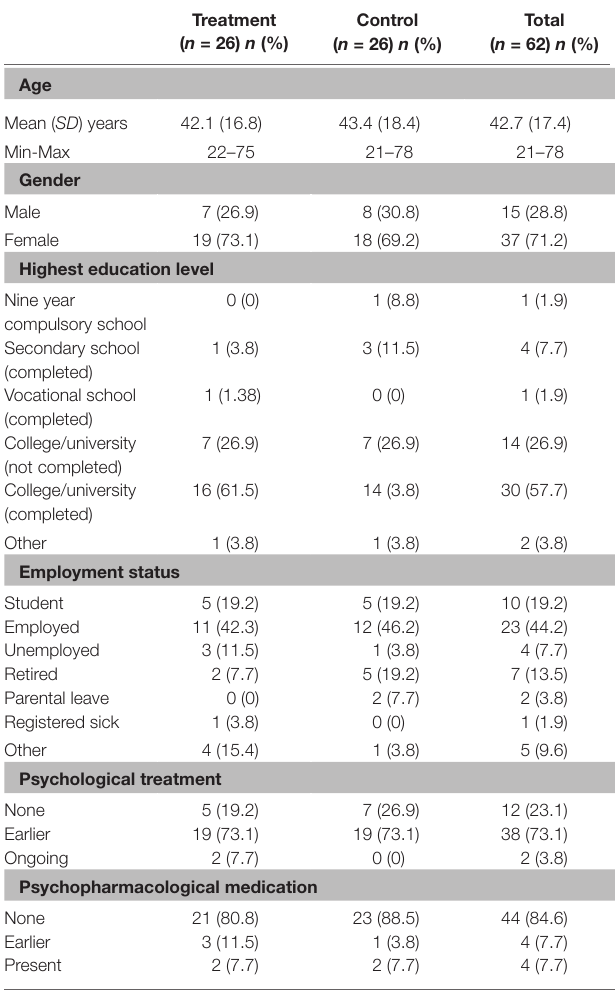
TABLE 1 | Demographic characteristics of the participants at